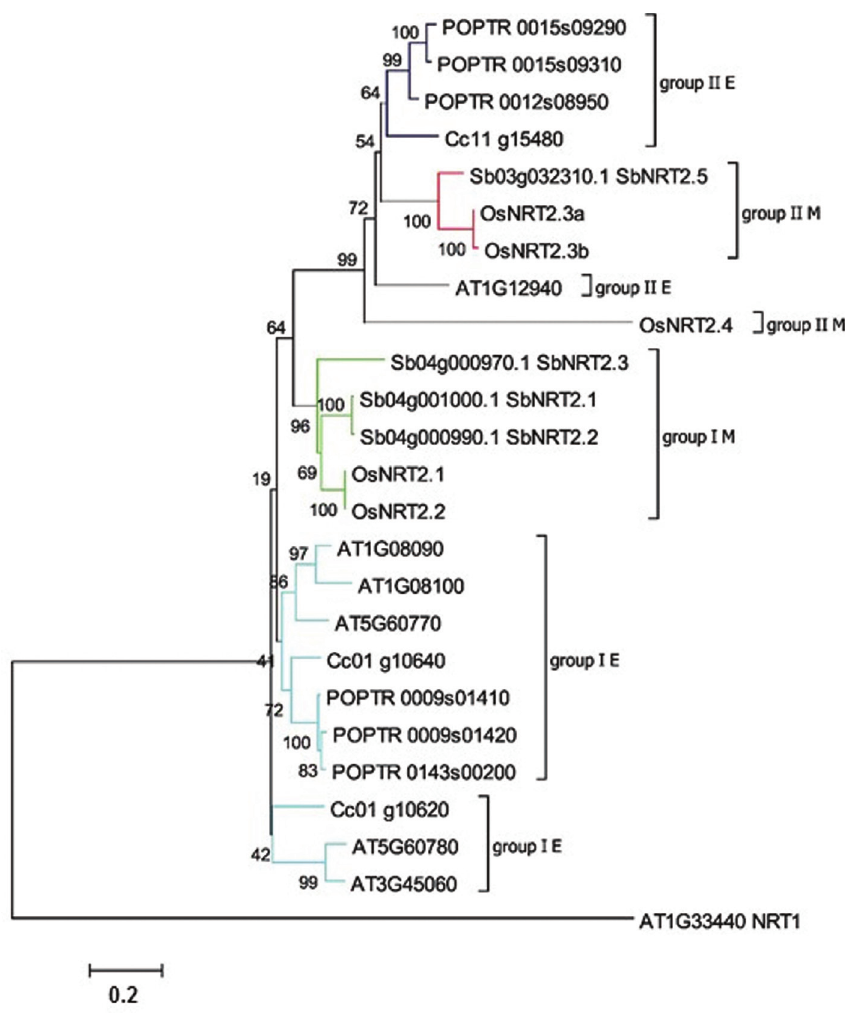
Figure 5 - Neighbor joining phylogenetic analysis of the NRT2 family. The tree was rooted using an A. thaliana NRT1 gene as an outgroup. Percent boot- strap values from 1,000 replicates are given. Taxonomic groups are colored based on groups: light blue to group I eudicot sequences; green represent monocot sequences in group I; dark blue and grey illustrate dicot sequences in group II; red and grey represent group B monocot sequences. Accession numbers are shown. Codes were retrieved from the Coffee Genome Hub for C. canephora and Phytozome for all other species. Phylogenetic groups were based in von Wittgenstein et al. (2014).